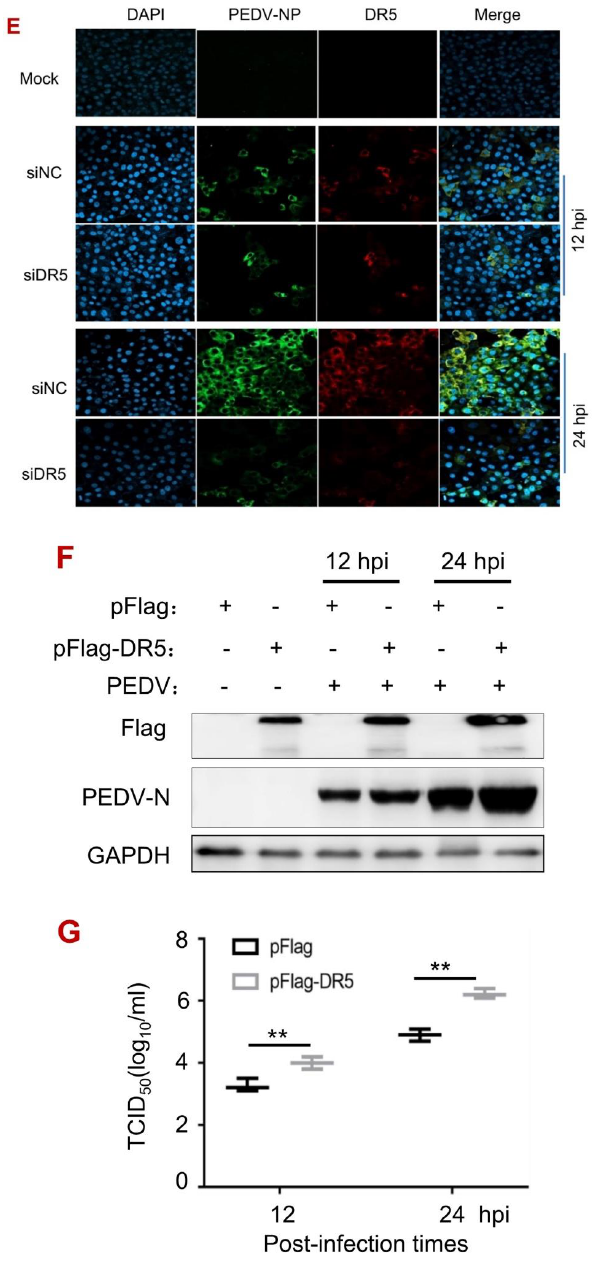
Figure 1. DR5 enhances viral replication of PEDV. ( A – E ), Vero cells were transfected with siRNA targeting DR5 (siDR5) or negative control (siNC), and then infected with PEDV at an MOI of 0.1, and cells were harvested at pointed time. The protein level was analyzed by Western blot with the indi- cated antibodies ( A ). Viral titration was performed using TCID 50 with the method of Karber ( B ). The mRNA level was subjected to RT-qPCR analysis for PEDV-N ( C ) and DR5 ( D ). For immunostaining ( E ), the infected cells were fixed at pointed time and incubated with mouse anti-PEDV N monoclonal antibody followed by FITC-conjugated goat anti-mouse secondary antibody (green). Then cells were incubated with rabbit anti-DR5 followed by TRITC-conjugated goat anti-mouse secondary antibody (1:100). Finally, the cells were counterstained with DAPI (blue), and the images were viewed under a Zeiss LSM900 confocal microscope (Fluoview 200 × ). ( F , G ), Vero cells were transfected with empty vector pFlag or recombinant plasmid pFlag-DR5. At 24 h post-transfection, cells were infected with PEDV at an MOI of 0.1, and cells were harvested at pointed time. The protein level was analyzed by Western blot with the indicated antibodies ( F ). Viral titration was performed using TCID 50 with the method of Karber ( G ). *, p < 0.05; **, p < 0.01; ***, p <